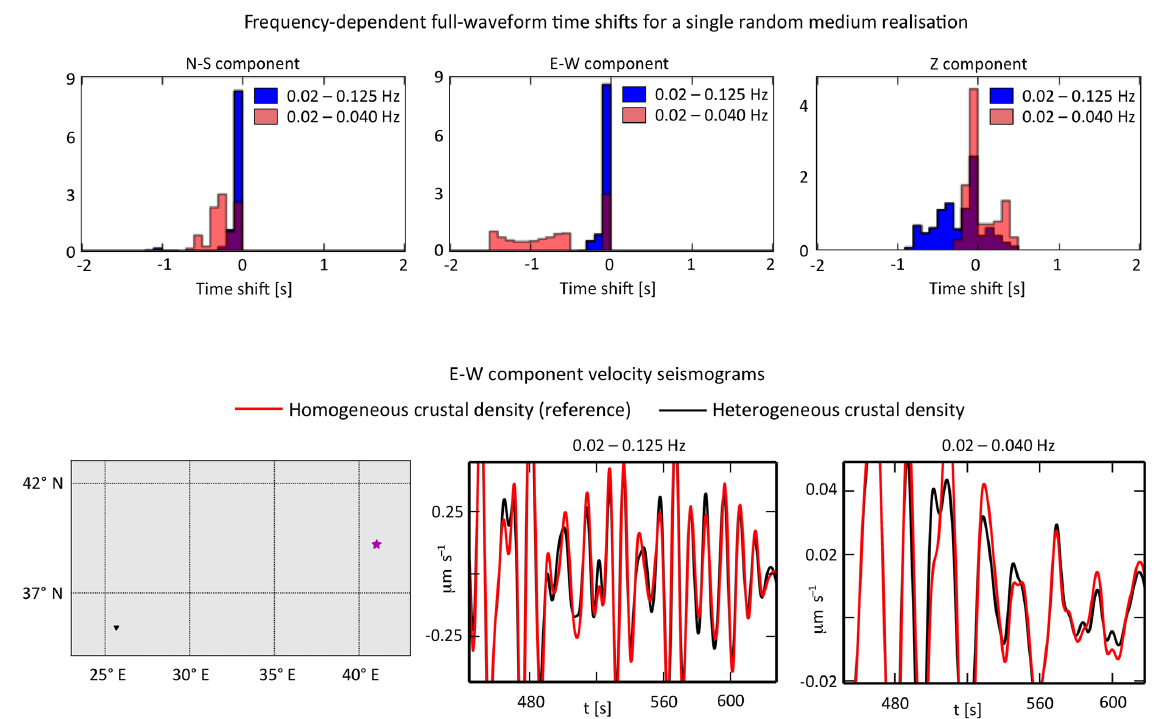
Figure 7. Top row: Normalised histograms of frequency-dependent time shifts for a single random medium realisation with 200 lateral and 20km vertical correlation length. The lower frequency band from 0 . 02 to 0 . 04Hz is shown in magenta, and the higher frequency and from 0 . 02 to 0 . 125Hz in blue. The three different components are plotted separately. The isolated tail of reduced time shifts for the lowest frequency band on the E–W component was observed for two out of five random medium realisations, the average of which is shown in Fig. 6. Bottom row: Comparison of E–W component synthetic seismograms for the homogeneous reference crust (red) and the 3-D heterogeneous crust (black) for the source-receiver geometry shown in the left panel. In the lower frequency band from 0 . 02 to 0 . 04Hz waves for the 3-D heterogeneous crust arrive early by ∼ 1s, thus contributing to the negative time shift tail in the E–W component histogram shown above. For the higher frequency band from 0 . 02 to 0 . 125Hz, a similar effect is not